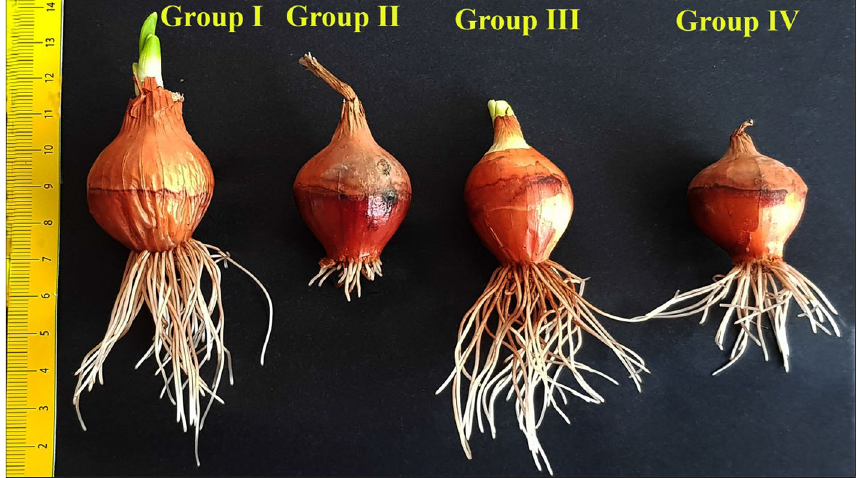
Figure 2. The germination situations at the end of seventh day of Allium cepa L. bulbs. Group I was treated with tap water, Group II was treated with 0.15 M NaCl, Group III was treated with 0.01 µM COR, Group IV was treated with 0.01 µM COR + 0.15 M